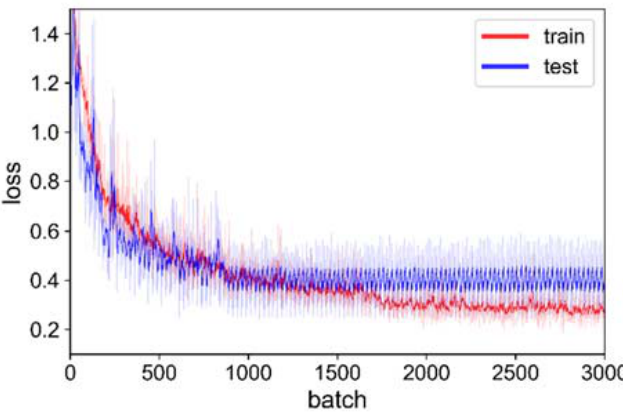
Figure 7. Training loss ( a ) and testing loss ( b ) during PointNet++ training. Losses were smoothed using the exponential moving average method TensorBoard.